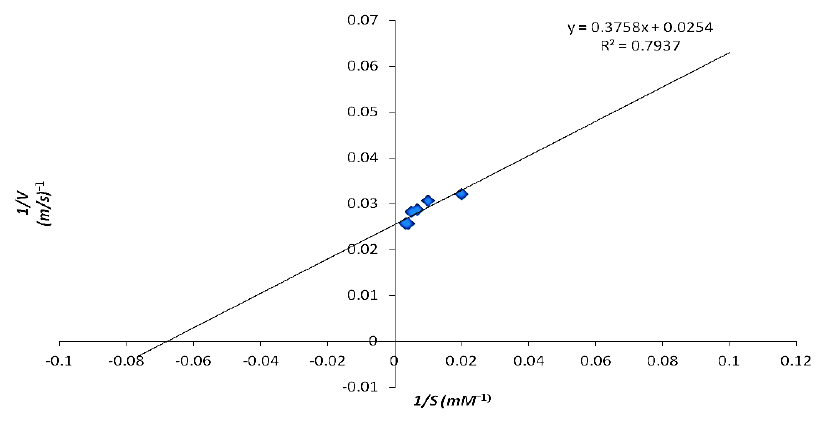
Figure 3: Double reciprocal plot of C. lanatus rind invertase activity using sucrose as substrate. Effect of pH on the activity of invertase from C.